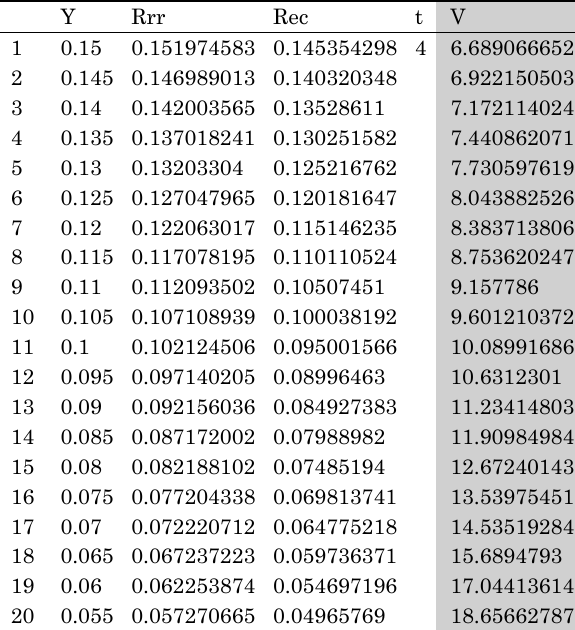
table 6. calculation of opinion of value with cyclical